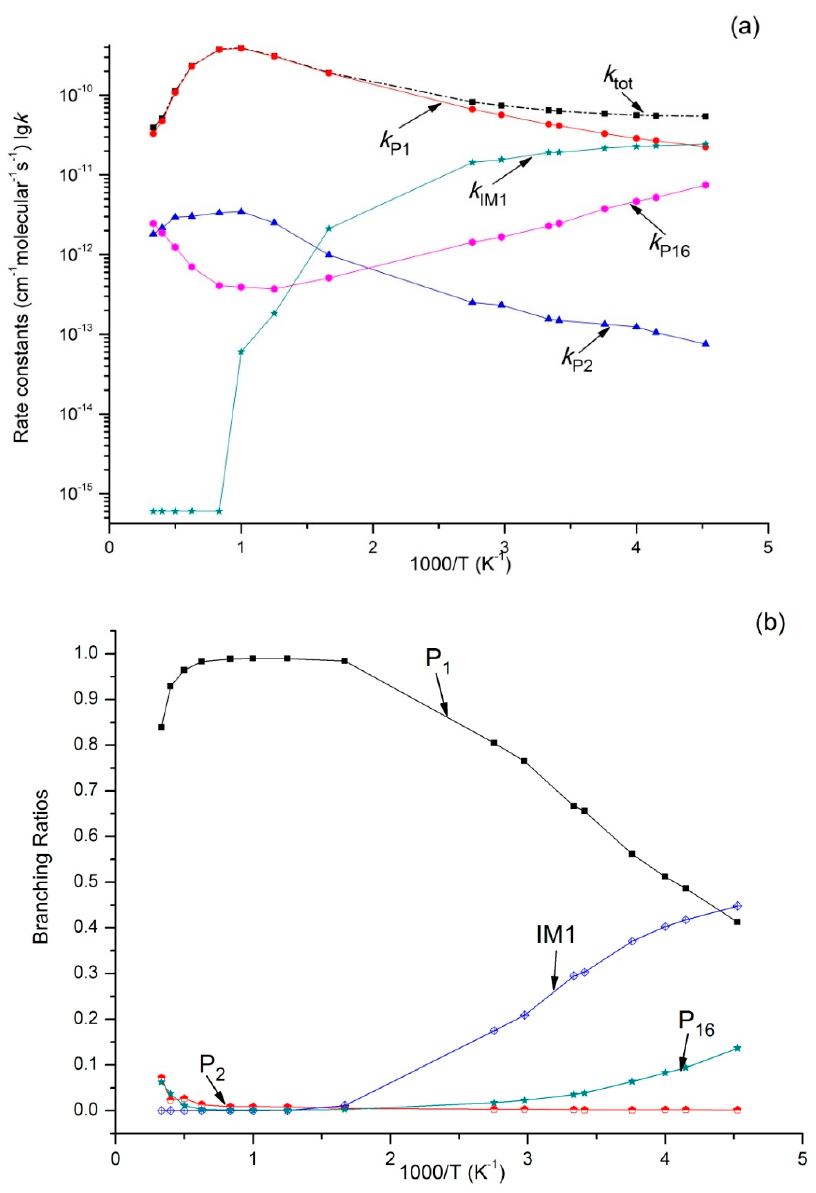
Figure 6. ( a ) Rate constants of total ( k tot ) and various reaction channels ( k P1 , k P2 , k P16 , and k IM1 ) at 100 bar in a temperature range of 220 K to 3000 K; ( b ) Branching ratios of various reaction channels at 100 bar in a temperature range of 220 K to 3000 K.